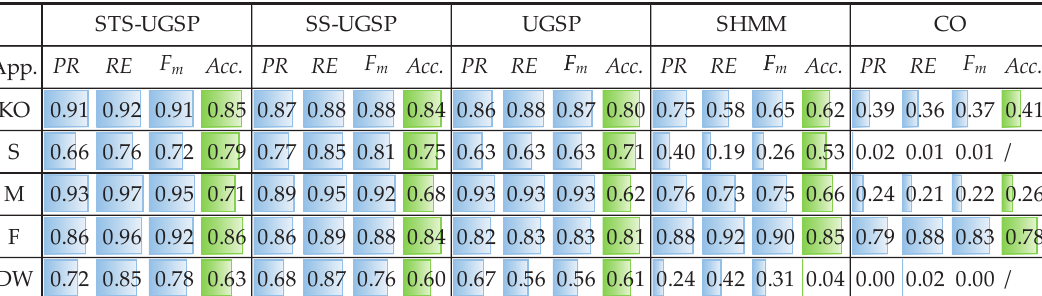
Figure 11. NILM Performance comparison for REDD House